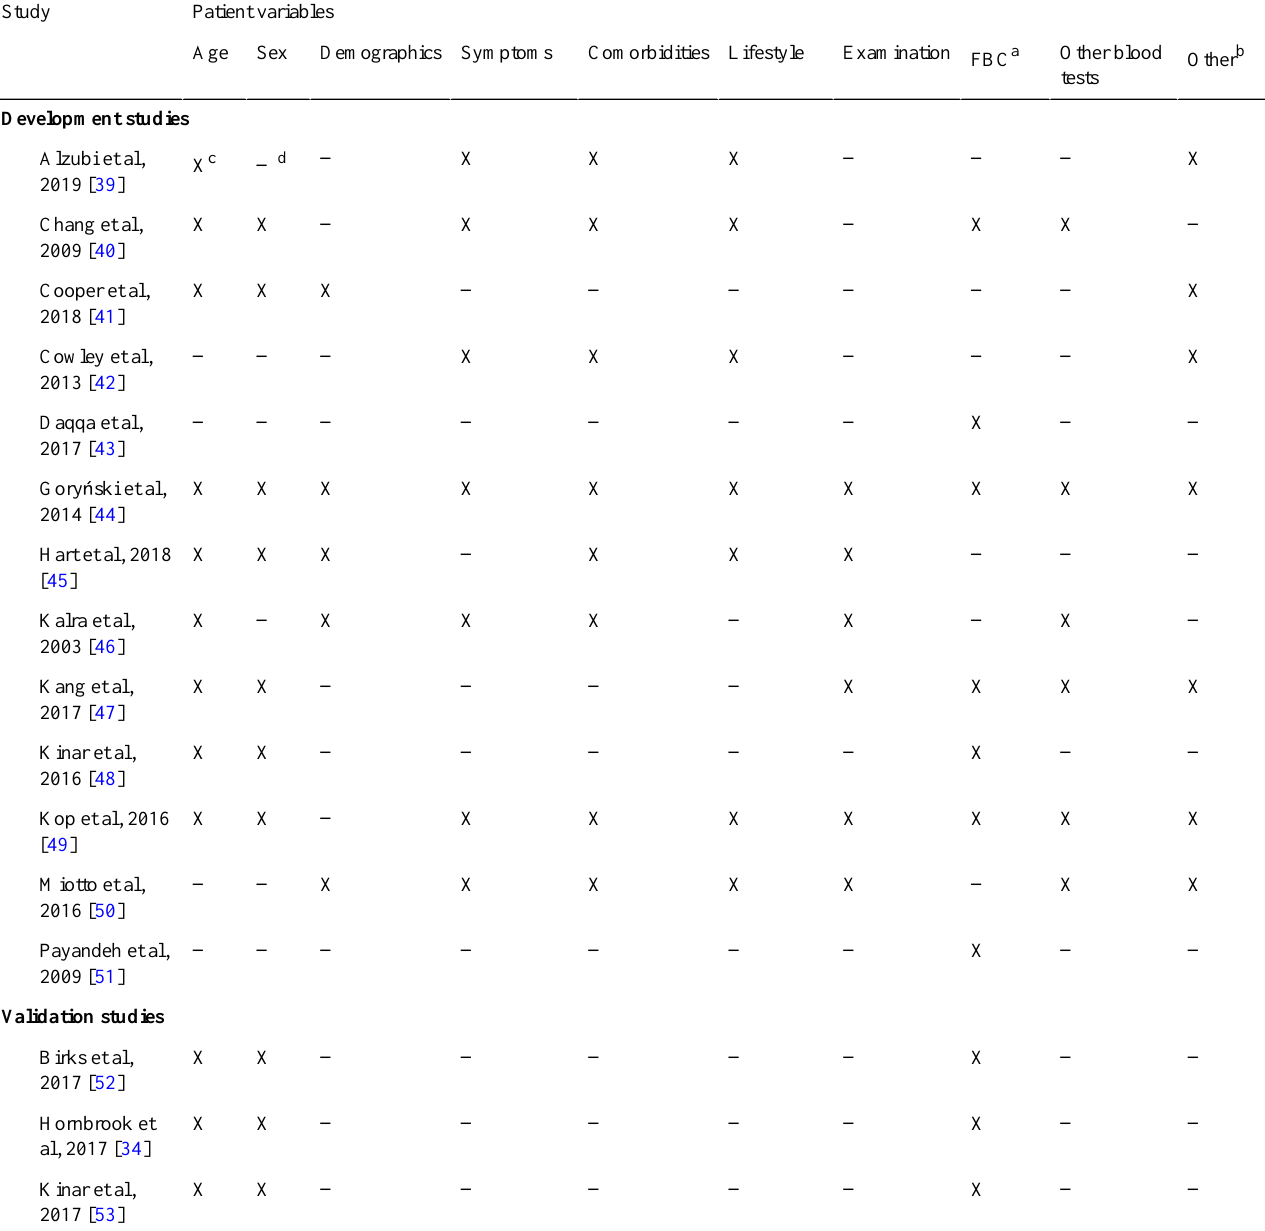
Table 2. Study details: patient variables. Patient